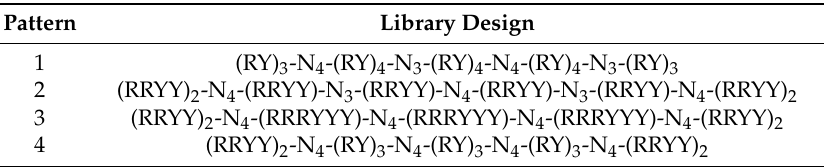
Table 1. Library design used by Martin et al.